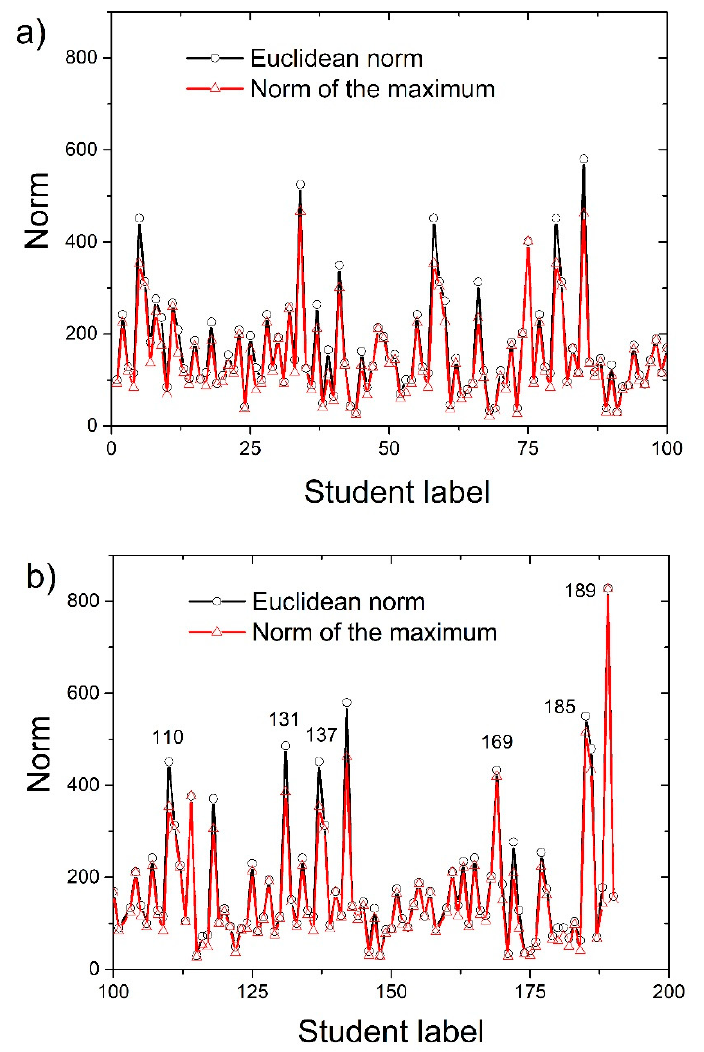
Figure 9. Euclidean norm and the norm of the maximum applied to the vector defined in Equation (8) as a function of the student label. In the upper panel, students from 1 to 100 are shown, and in the lower panel, students from 101 to 200. The students labeled as 110 (M), 131 (F), 137 (M), 169 (F), 185 (M), and 189 (F) appear in this classification only. The letter “M” between parentheses stands for male and the letter “F” for female.